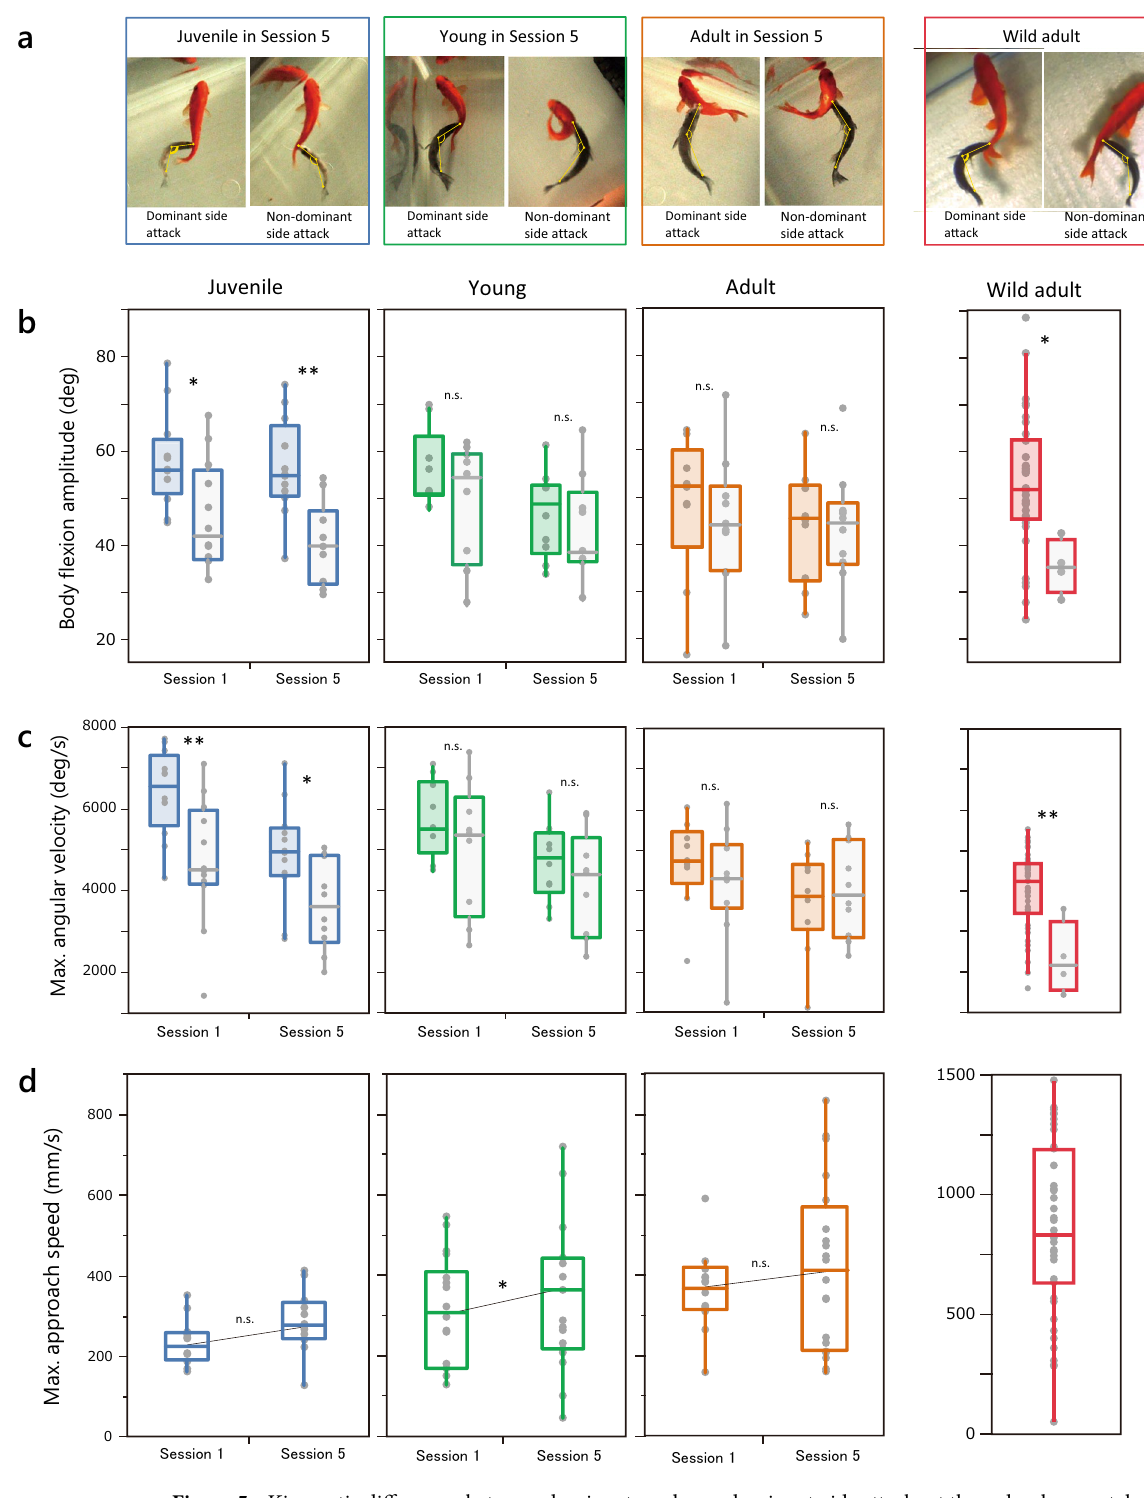
Figure 5. Kinematic differences between dominant- and non-dominant-side attacks at three developmental stages. ( a ) Representative pictures of dominant- (shaded) and non-dominant- (open) side attacks of three lefty predators at different stages of development in Session 5: juvenile, young, and adult. The rightmost images show predation by a wild adult (SL, 89.3 mm). Boxplots of the amplitude ( b ) and maximum angular velocity ( c ) of body flexion during attacks in Sessions 1 and 5 at different development stages (juvenile, N = 12; young, N = 10; adult, N = 10). ( d ) Maximum approach speed towards prey fish. The values of wild adults (N = 11) are shown on the extreme right. Wilcoxon rank-sum test was used for comparisons between dominant and non-dominant sides. * p < 0.05; ** p <